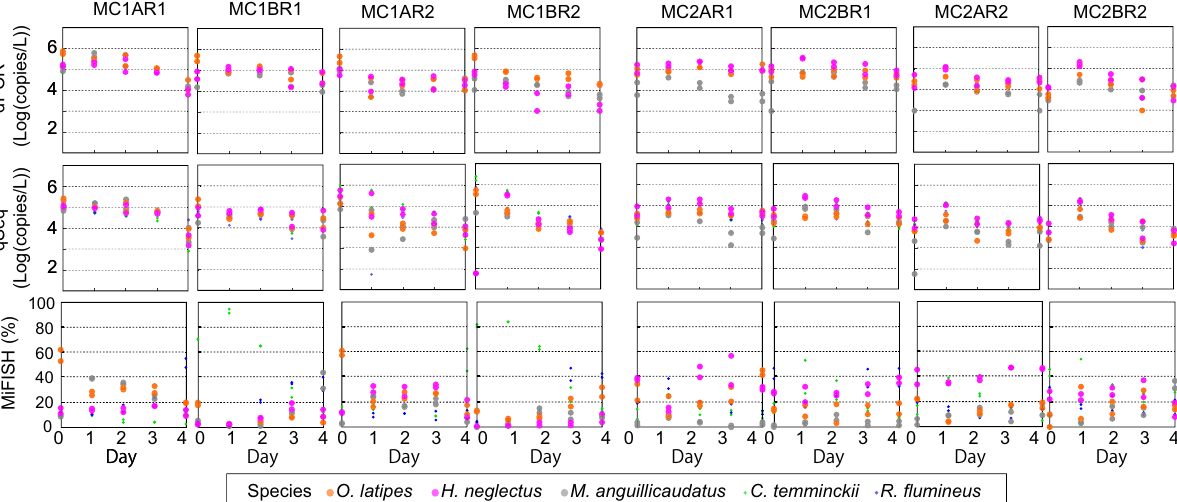
Figure 3. Quantification of eDNA released from 5 fish species in the aquarium experiments. The 12 plots on the left show results from the aquaria using mock fish community 1 while the 12 plots on the right show the results from mock fish community